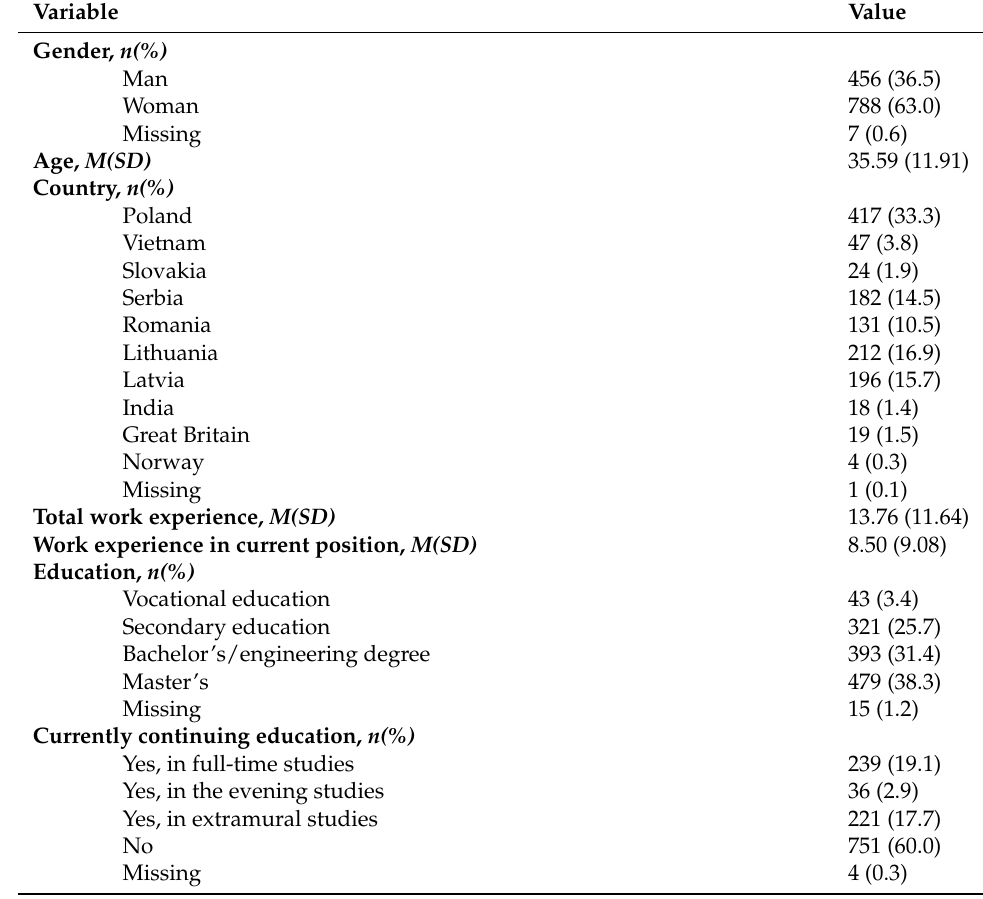
Table 1. Descriptive statistics of surveyed